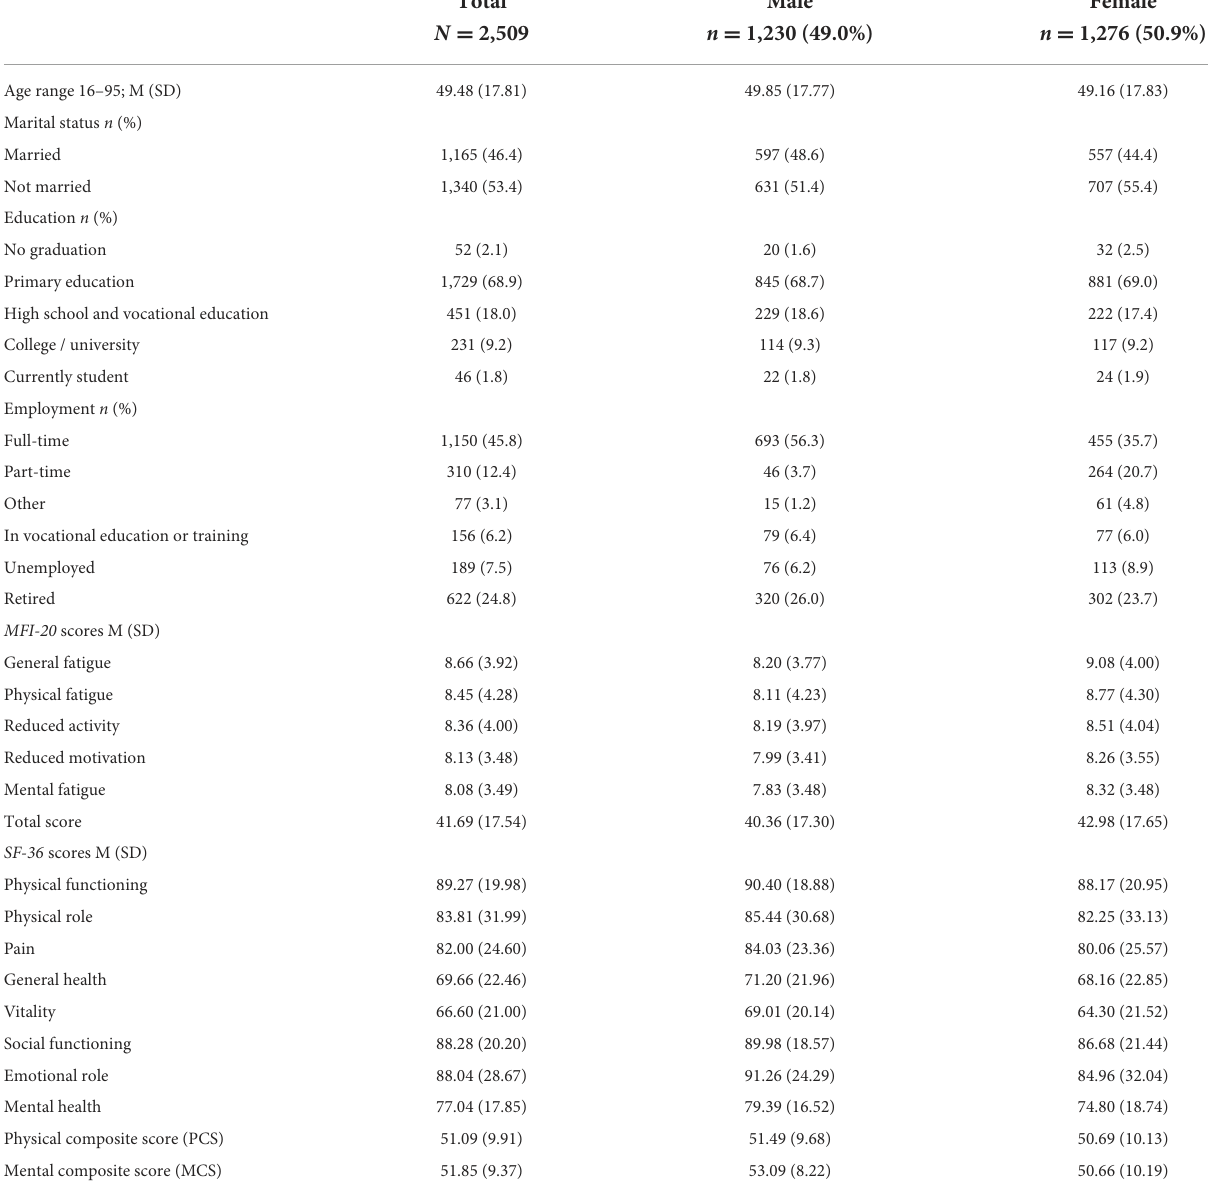
TABLE 1 Sociodemographic characteristics, MFI-20 and SF-36 scores for the total sample ( N = 2,509), and for the male participant and female participant.